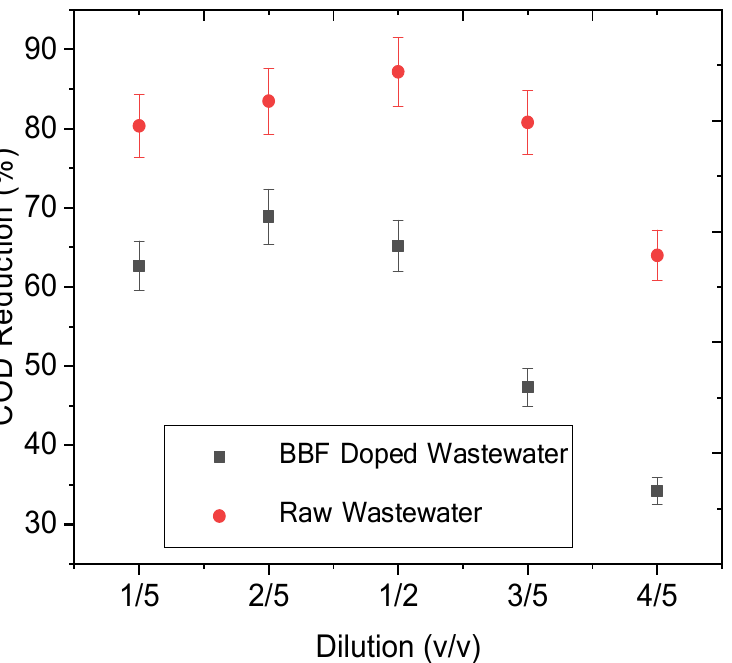
Figure 9. Evaluation of the effect of wastewater matric dilution on COD reduction: wastewater pH = 5; doped wastewater pH = 7; Δ P = 5 bars; treatment time = 15 min.